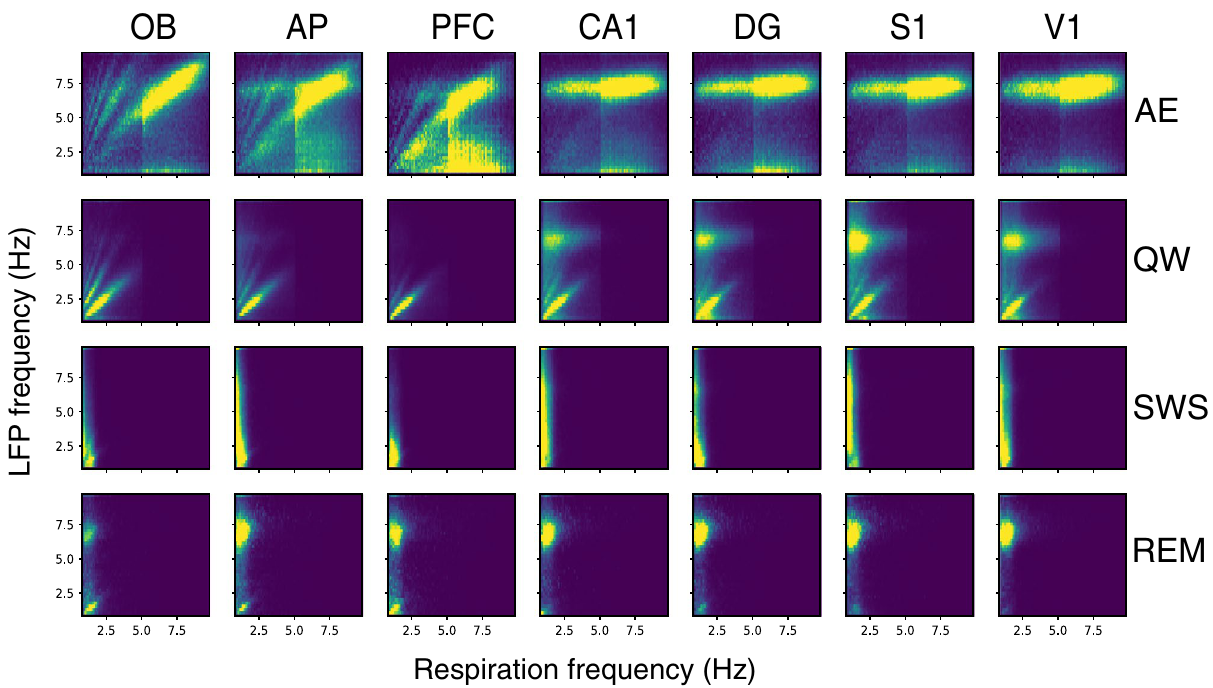
Figure 5. Covariation between LFP and respiration frequencies. Covariation maps, averaged across rats, obtained from LFP signals recorded under ambient air in OB, AP, PFC, CA1, DG, S1, and V1. Y-axis represents LFP frequency and X-axis respiratory frequency. The maps are 2-dimensional distributions of joined LFP- respiration frequencies across time (see methods for details), normalized so that the total sum is 1. Point density is represented on a color scale ranging from blue (0) to yellow (map maximum) as the point density increases. For each structure and state, see sample size (number of rats in the average) in Table